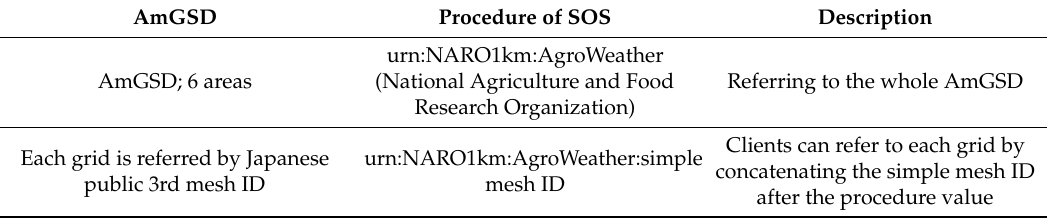
Table 1. Mapping the coverage and grid of AmGSD (Agro-meteorological Grid Square Data system) to SOS (Sensor Observation